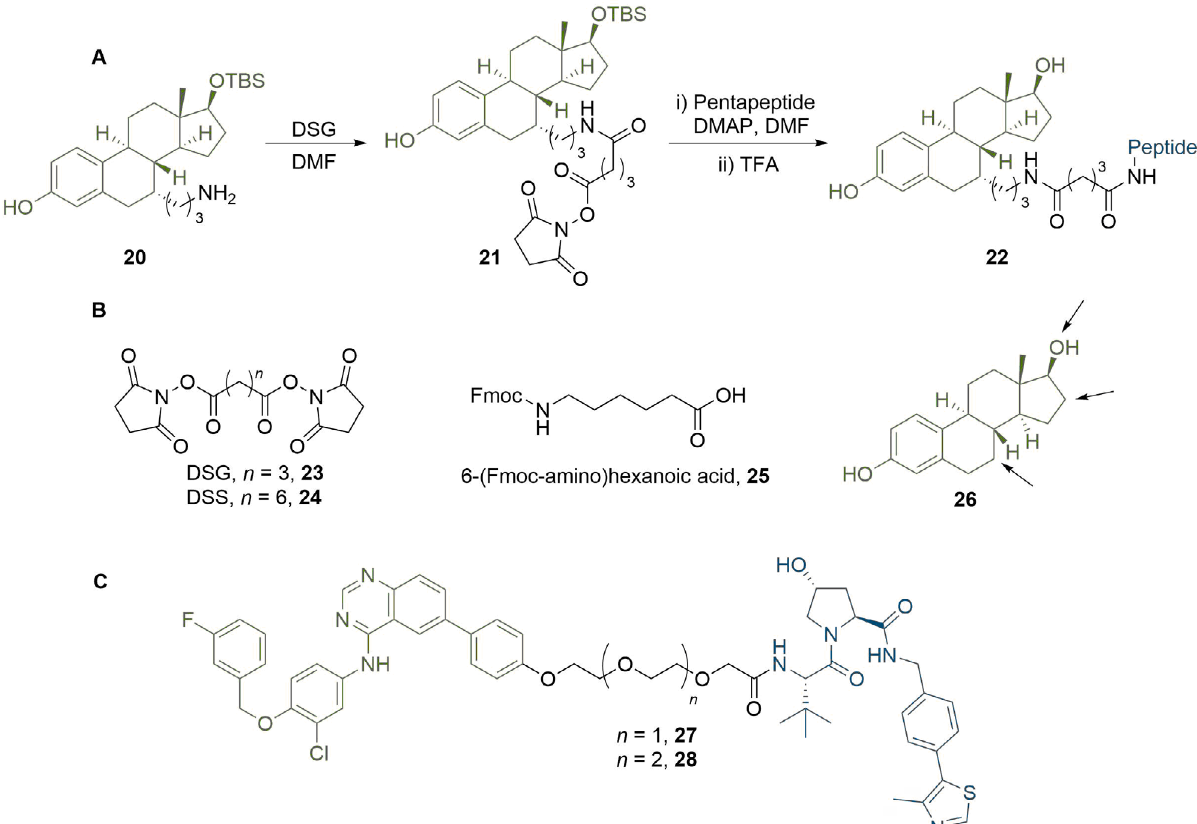
Figure 6. Effect of PROTAC linker length and conjugation site. A. In a representative PROTAC synthesis by Cyrus et al. [ 65 ], 20 was reacted with DSG to install an amide-linked alkyl linker. The product 21 was then reacted with the E3-binding pentapeptide sequence to displace the second succinimidyl moiety and obtain PROTAC 22; B. commercially available linker building blocks used by Cyrus et al. [ 65], include DSG (23), DSS (24), and Fmoc-protected acid 25. The structure of oestradiol (26) is shown with arrows pointing to potential sites of linker conjugation; C. extension of the PEG linker in EGFR and HER2 degrader 27 by one unit abolished HER2 activity to afford selective EGFR PROTAC 28